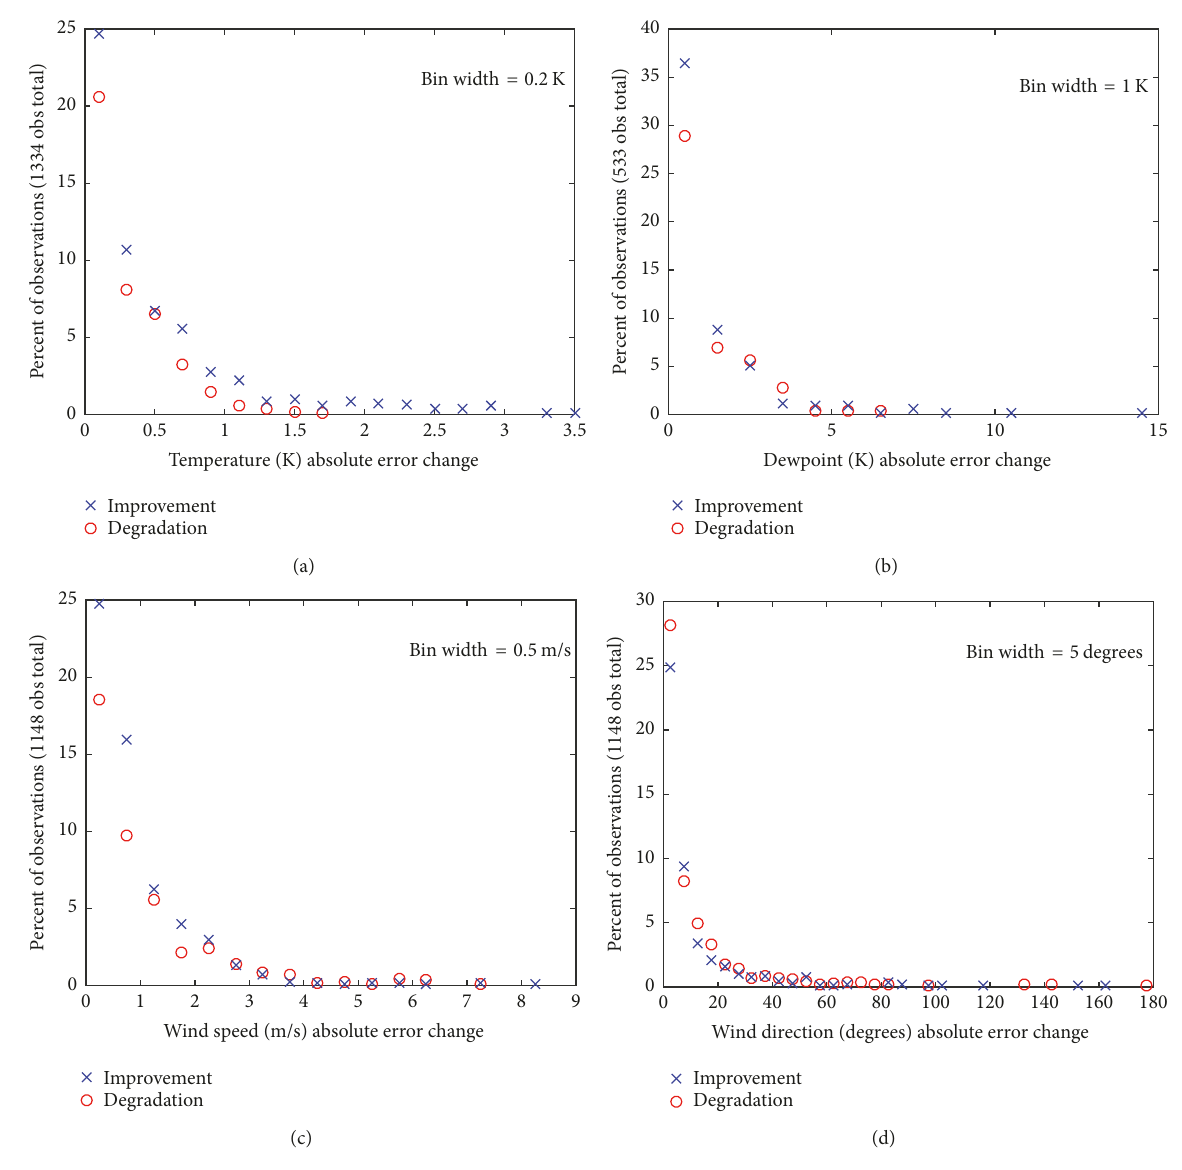
Figure 5: Distribution of the differences between the absolute value of model error in Exp. H45V75 and the absolute value of model error of Exp. Control for (a) temperature, (b) dewpoint, (c) wind speed, and (d) wind direction as verified against above-surface observations during the 1–6 h forecast (19 UTC). Bins representing model-observation pairs where the absolute value of model error in Exp. H45V75 is smaller than that in Exp. Control are denoted by “Improvement,” whereas pairs where Exp. H45V75 has the larger error are denoted by “Degradation” but are plotted on the positive 𝑥 -axis to simplify comparison against mirror “Improvement”